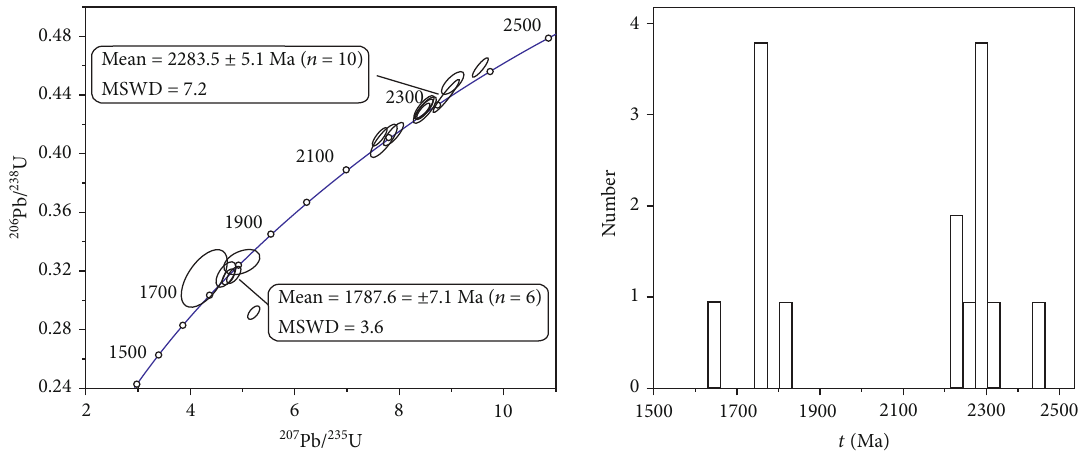
Figure 7: Zircon U-Pb age Concordia diagram and histogram of